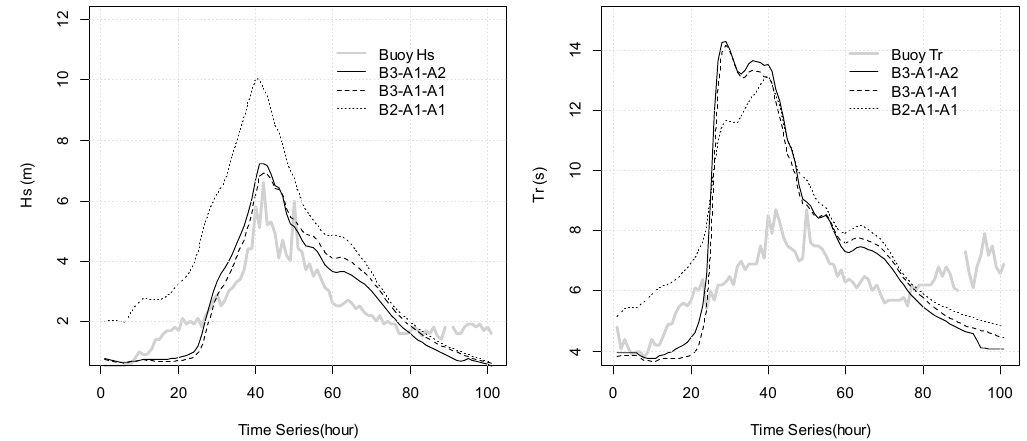
Figure A10. Comparison of typhoon waves induced by Typhoon Meranti (14-2016) at buoy Pratas: the standard H10 is indexed as B2-A1-A1, the model with varying parameter b without an asymmetric typhoon structure is indexed as B3-A1-A1, and MH10 is indexed as B3-A1-A2. Appendix B. Table A1. Paired peak-value of buoy extremes and simulated extremes in every case. Index of Typhoon